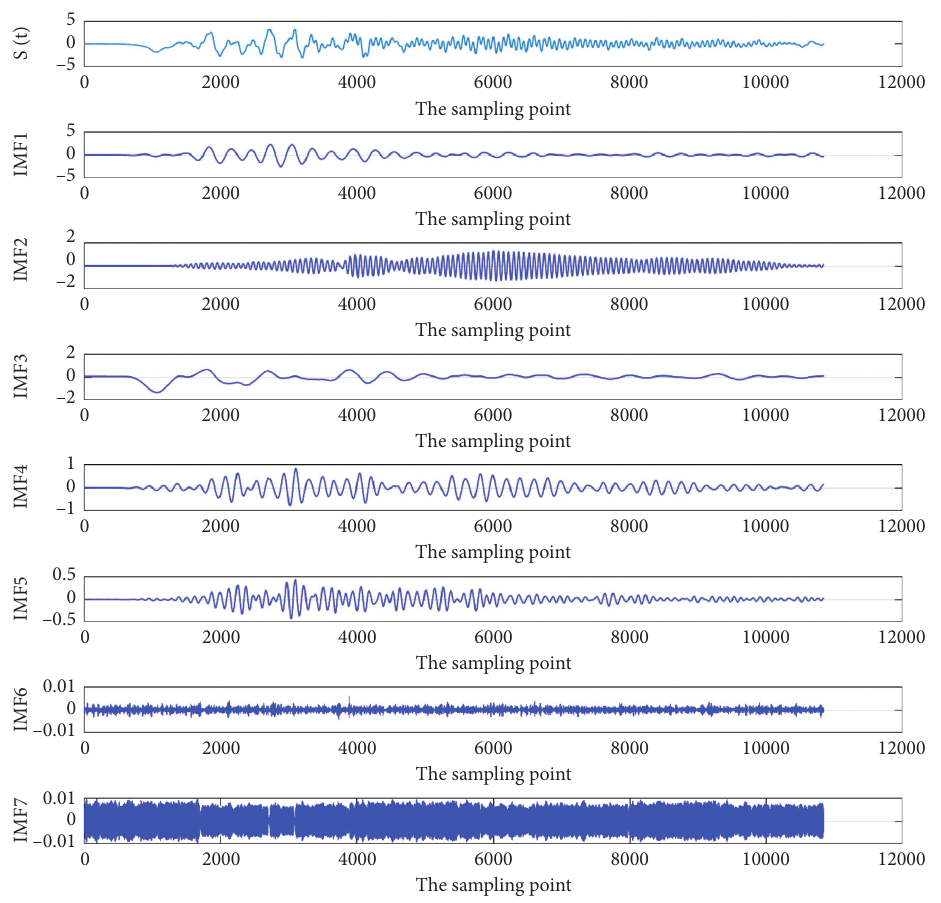
Figure 8: The decomposition results of dynamic signal by VMD.